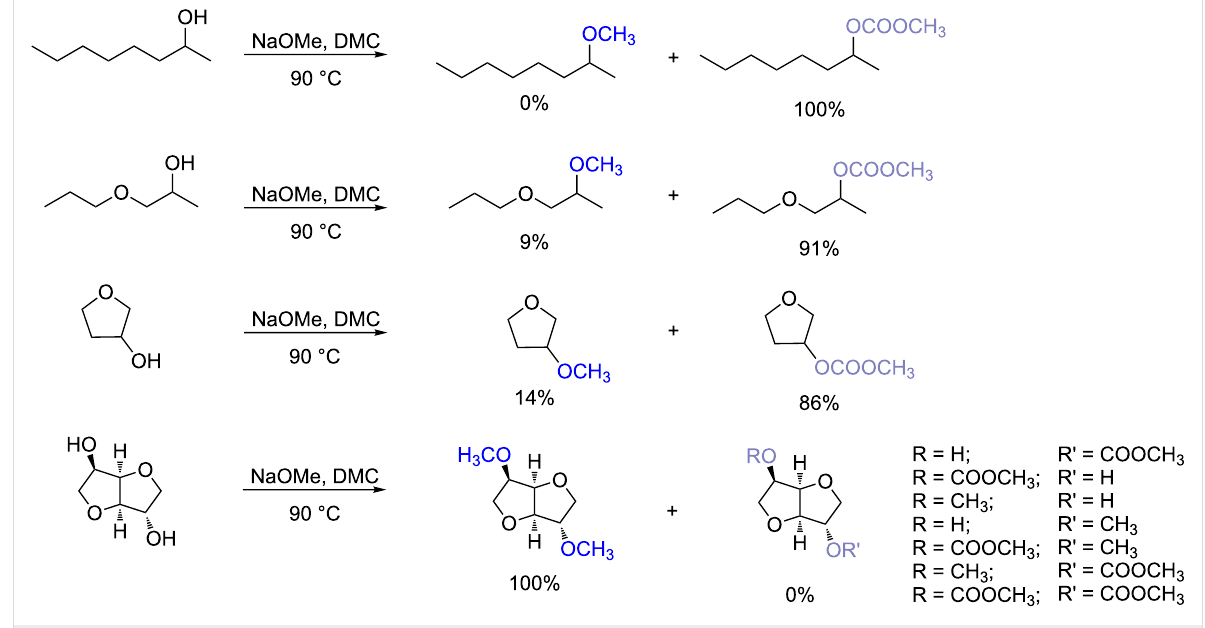
Scheme 6: Comparison of the reactivity of isosorbide with other secondary alcohols in methylation reaction. Reaction conditions: Isosorbide DMC 1:50 equiv; reaction time 20 h; 90